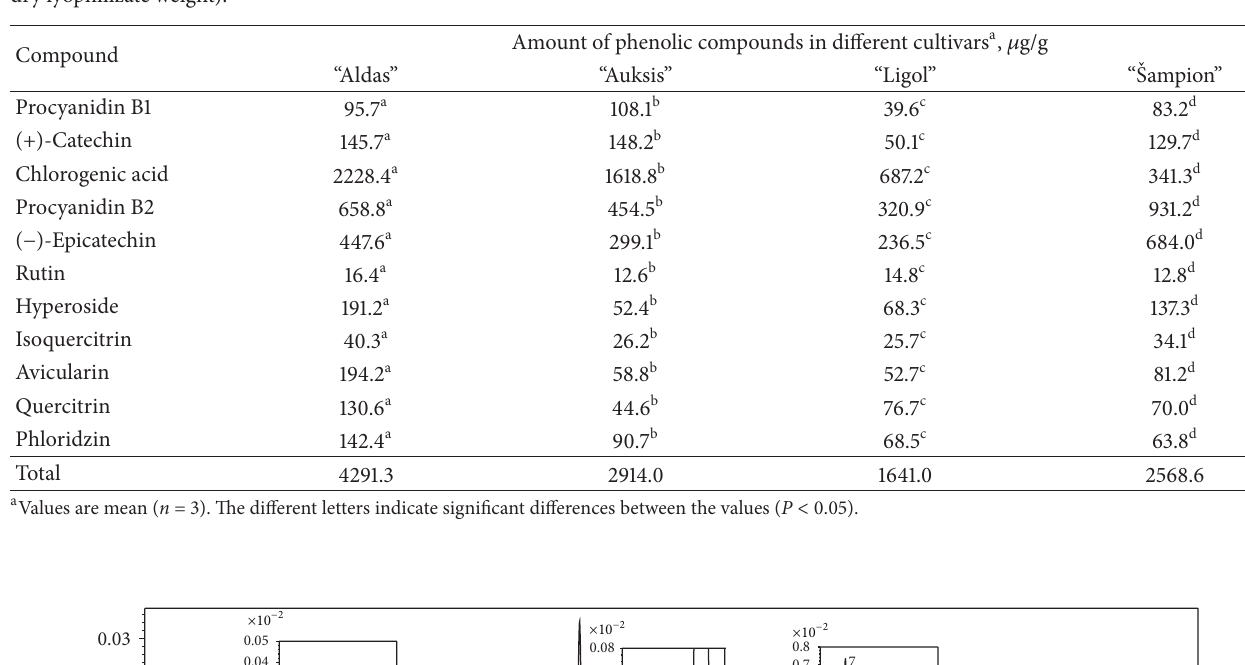
Table 3: Content of phenolic compounds in ethanol extracts obtained from the apples of cultivars grown in Lithuania (expressed for absolute dry lyophilizate weight).